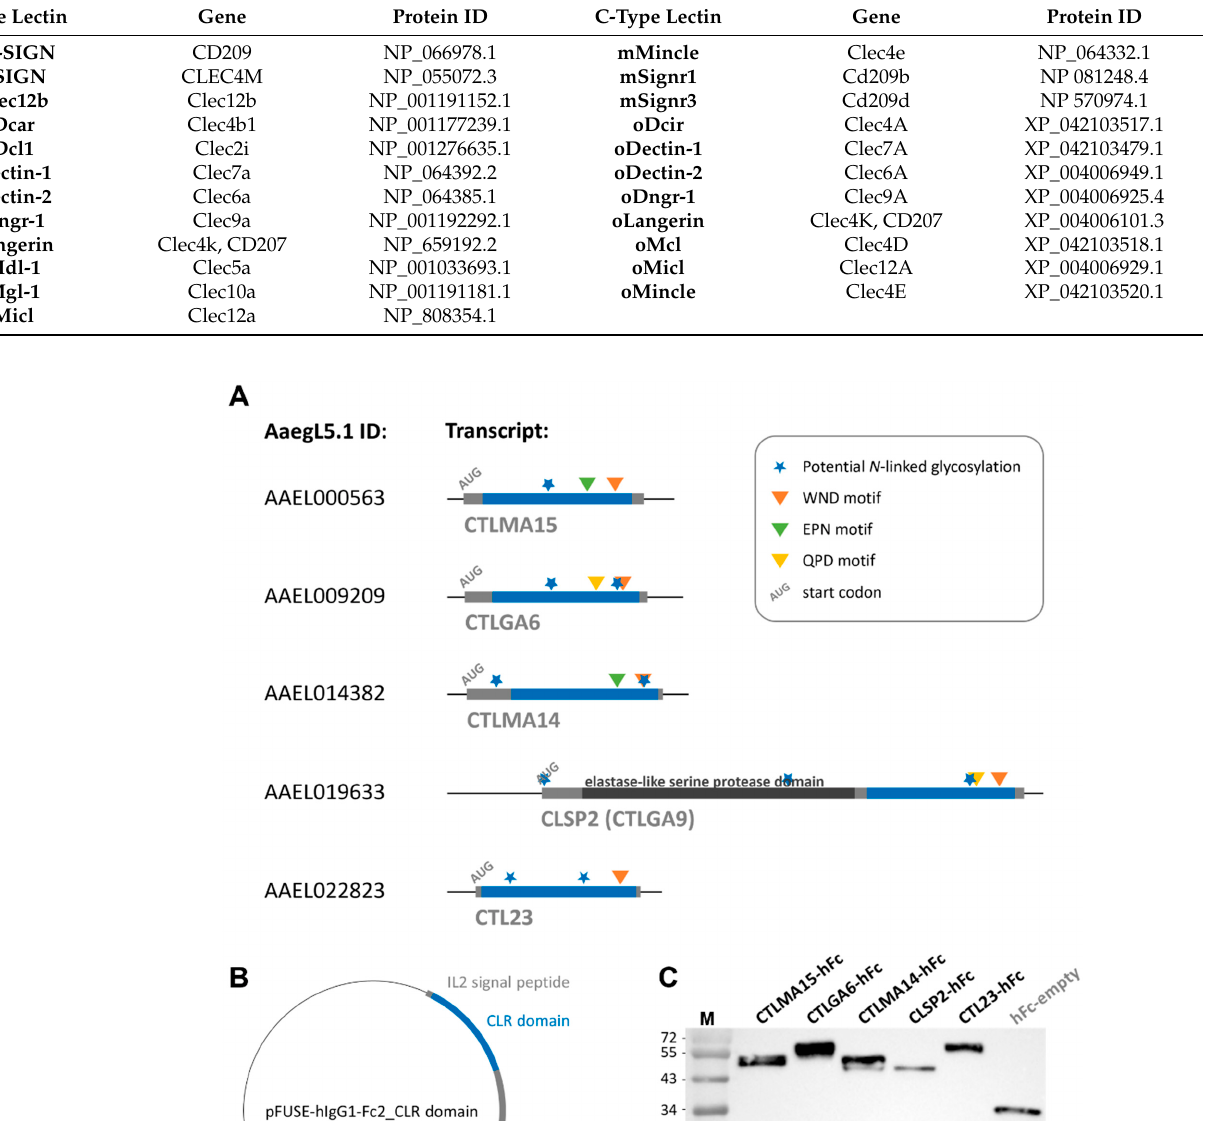
Table 2. National Centre for Biotechnology Information (NCBI) Protein IDs, as well as gene name for each human, murine, and ovine C-type lectin used for phylogenetic analysis listed.